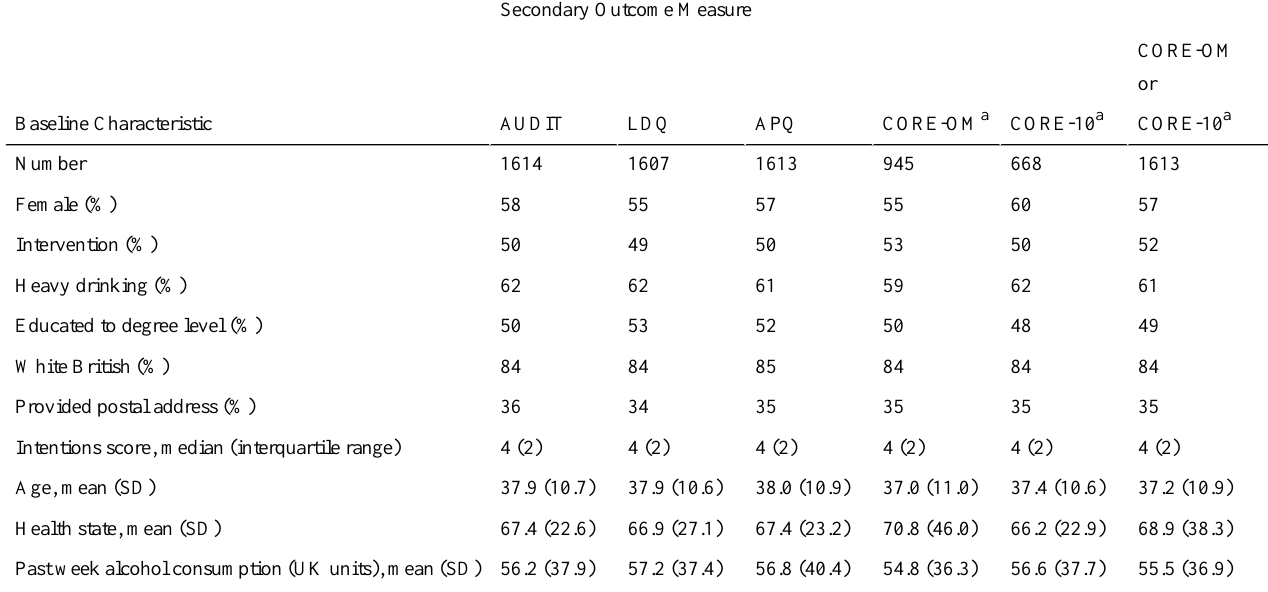
Table 1. Baseline characteristics of groups randomized to four secondary outcome measures